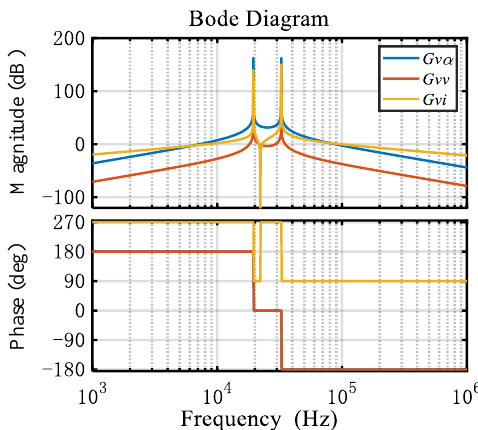
Figure 6. Open loop system bode diagram of G vα ( s ), G vv ( s ) and G vi ( s ).